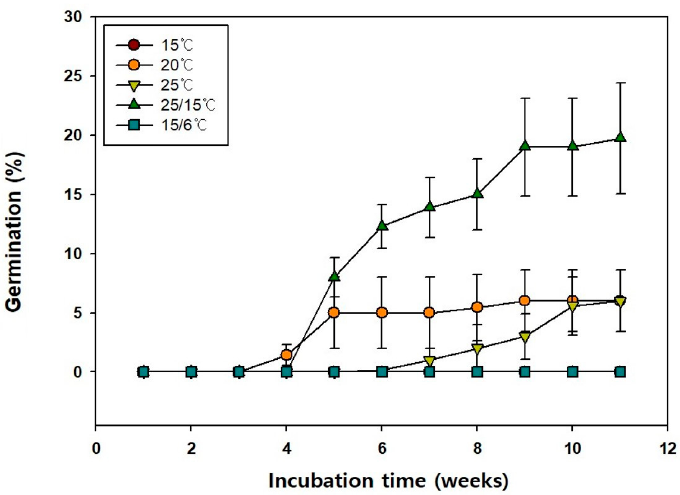
Figure 4. Germination of Vaccinium oldhamii seeds incubated at alternate and constant temperature. Seeds collected in 2021 were used for this study. Vertical bars represent Standard error (n = 4). Table 2. Germination characteristics of Vaccinium oldhamii Miq. seeds under different germination temperature and Gibberellic acid (GA 3 ) treatments.